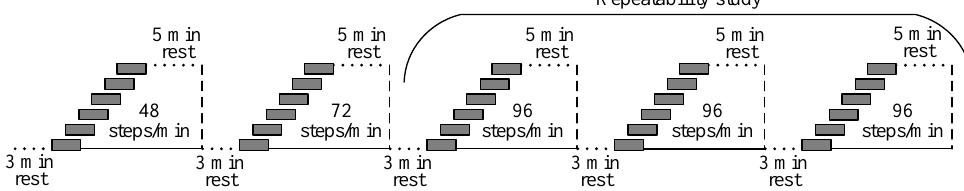
Figure 2. Protocol for acquisition of heart rate and altitude during standardized stair climbing